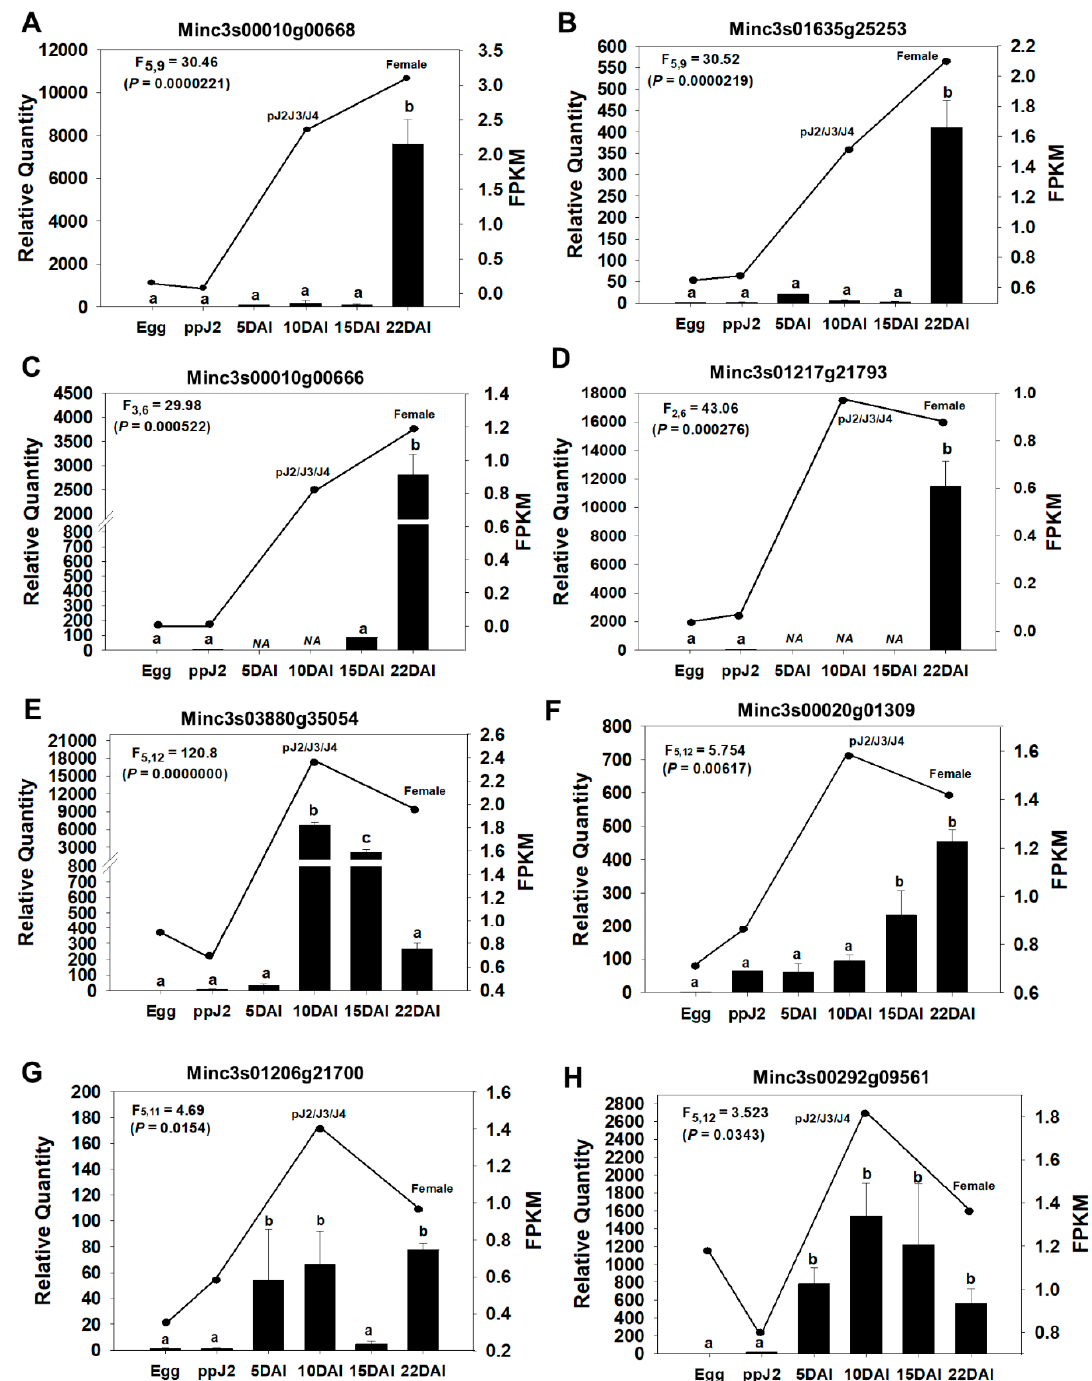
Figure 4. RNA-seq and RT-qPCR expression profiles of PPN-specific candidate effector genes during the M. incognita life cycle. Relative mRNA levels of eight genes ( A – H ) at different stages of the nematode life cycle during its compatible interaction with Nicotiana tabacum. RT-qPCR data are shown in bars (mean ± standard error) with values in the left “y” axis and analyzed in six stages: egg, ppJ2, and endophytic phases at 5, 10, 15, and 22 days after inoculation (DAI). RNA-seq in silico data are shown as a line plot with values displayed at the right “y” axis (FPKM) and analyzed at four stages: egg, ppJ2, and endophytic phases pJ2/J3/J4 and female. RT-qPCR expression data were analyzed using the SATqPCR tool [57], with expression values statistically analyzed using ANOVA and Tukey’s test ( p < 0.05). Different letters indicate statistically significant differences between samples.